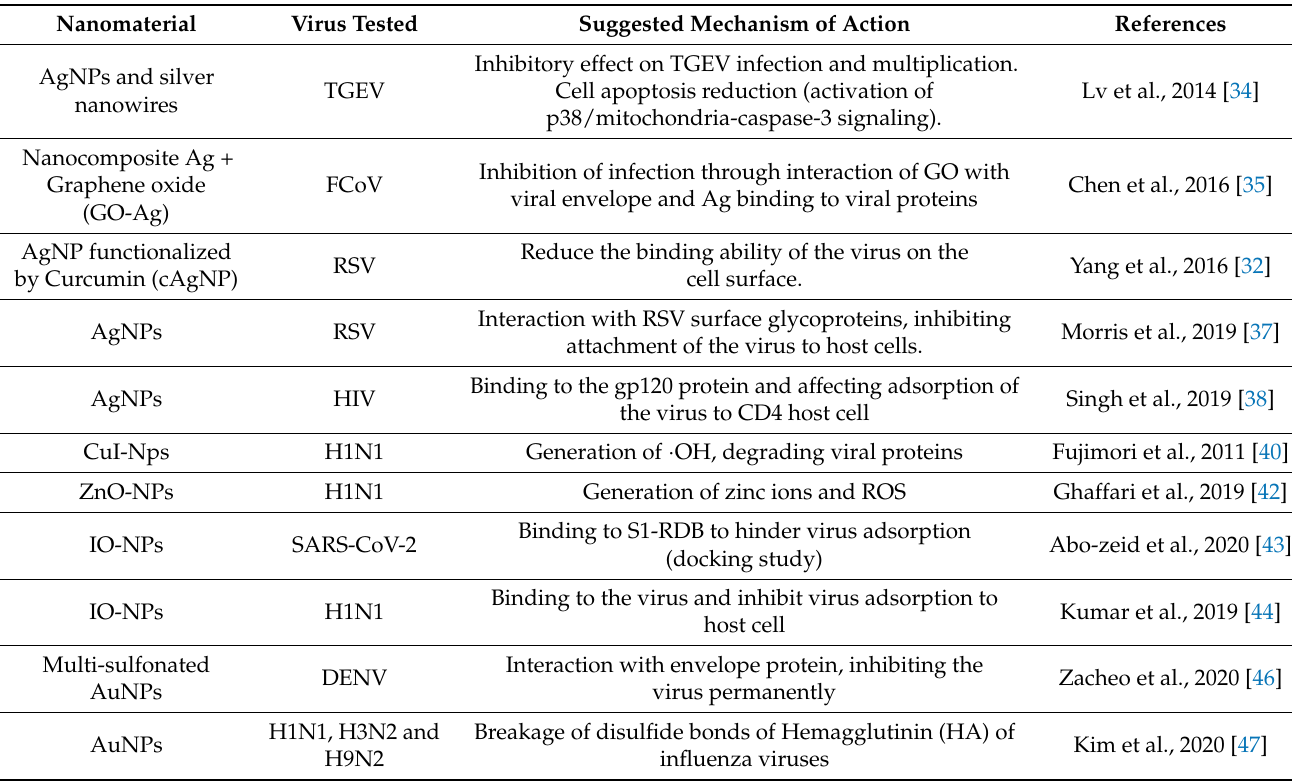
Table 1. Studies of nanometallic materials applied as antivirals reported in this